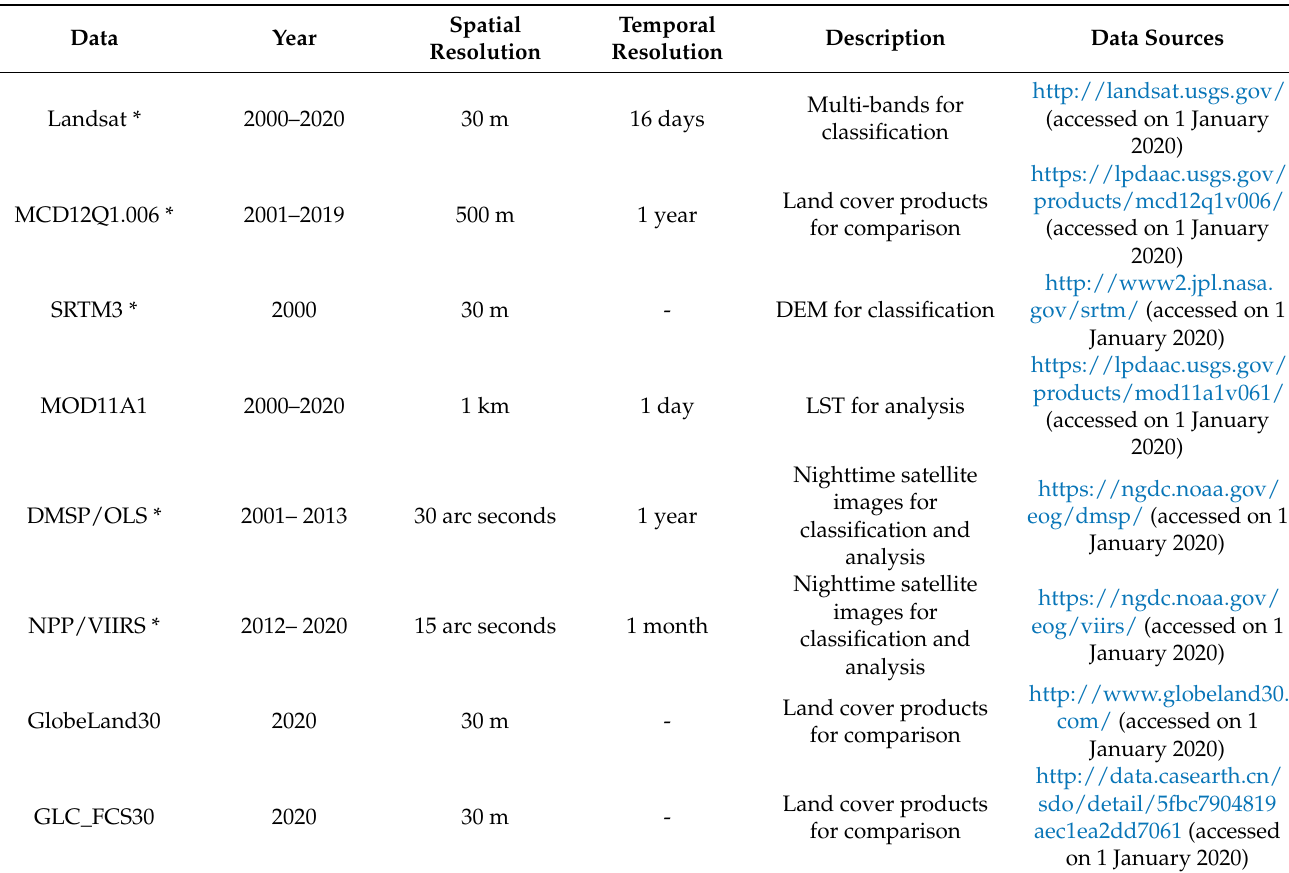
Table 2. Datasets used in this